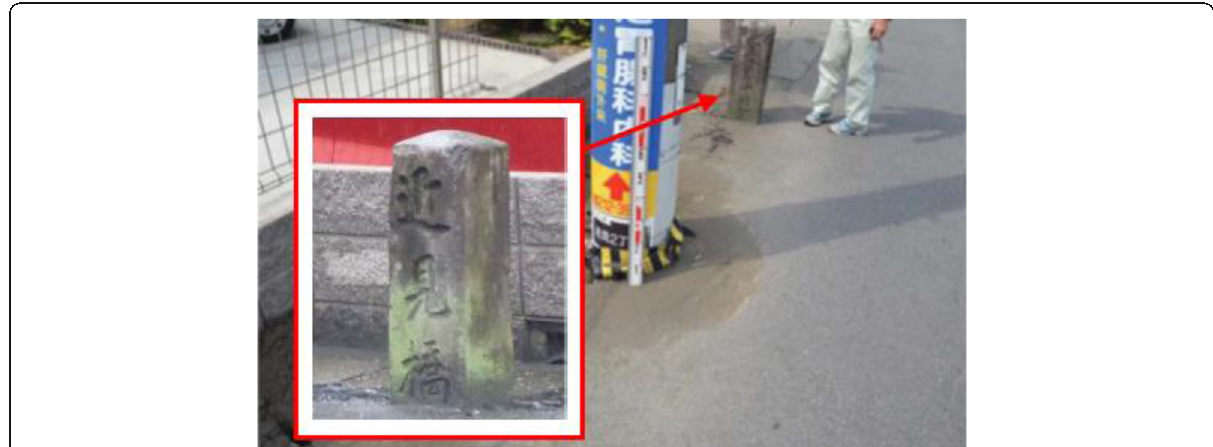
Fig. 16 The guide pillar of the former Chikami